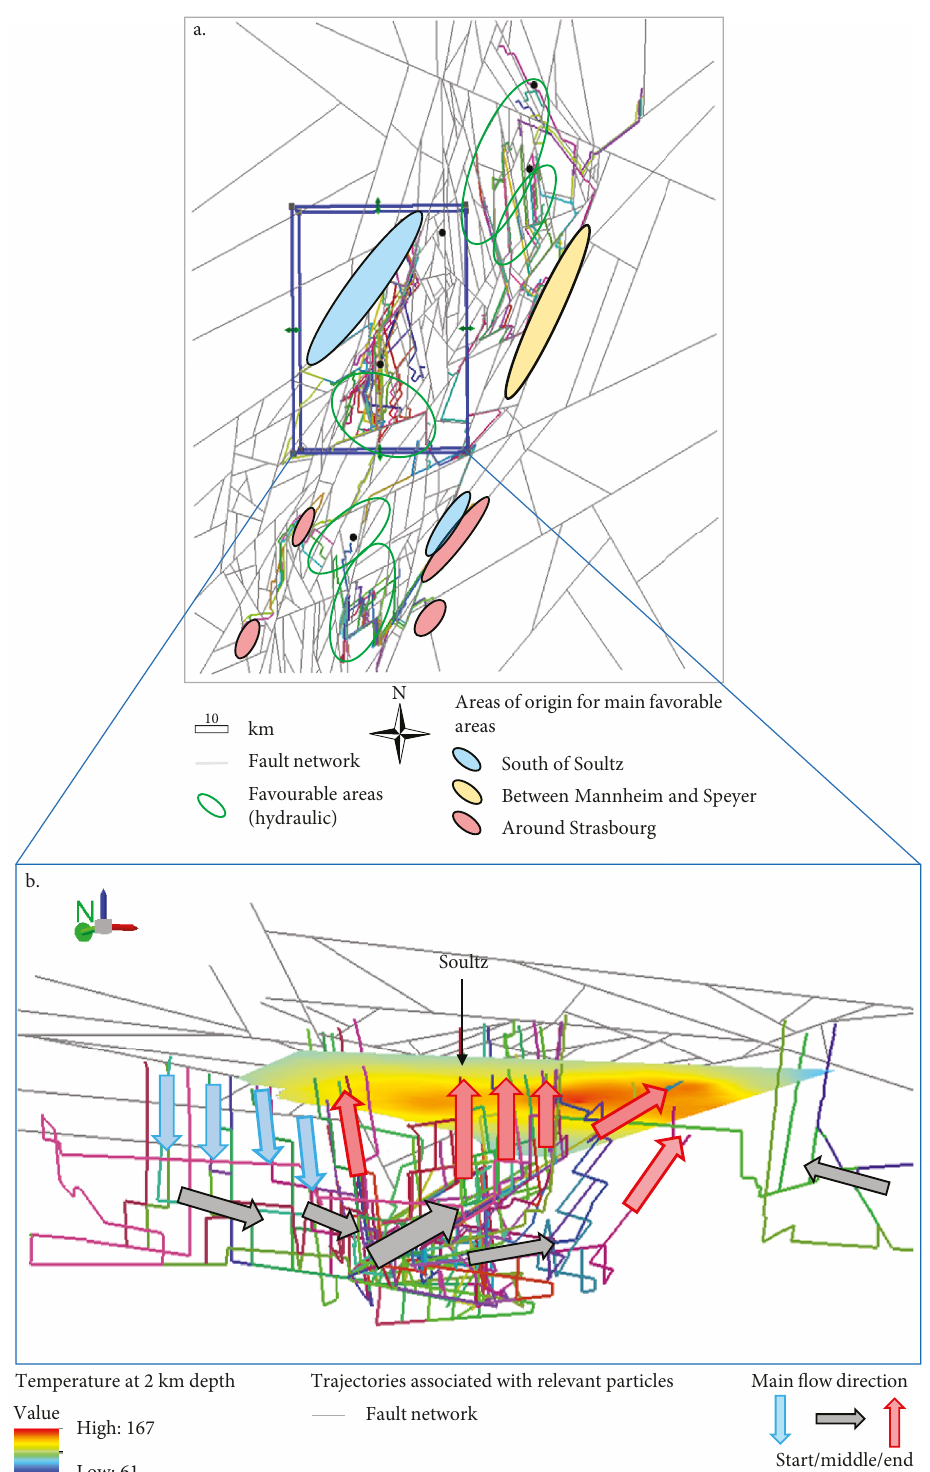
Figure 10: (a) Plan view of trajectories associated with relevant particles and areas of origin of particles associated with favourable areas. (b) 3D cross-view (south-side view) of trajectories in the favourable area located close to Soultz-sous-Forêts according to the blue rectangle drawn in